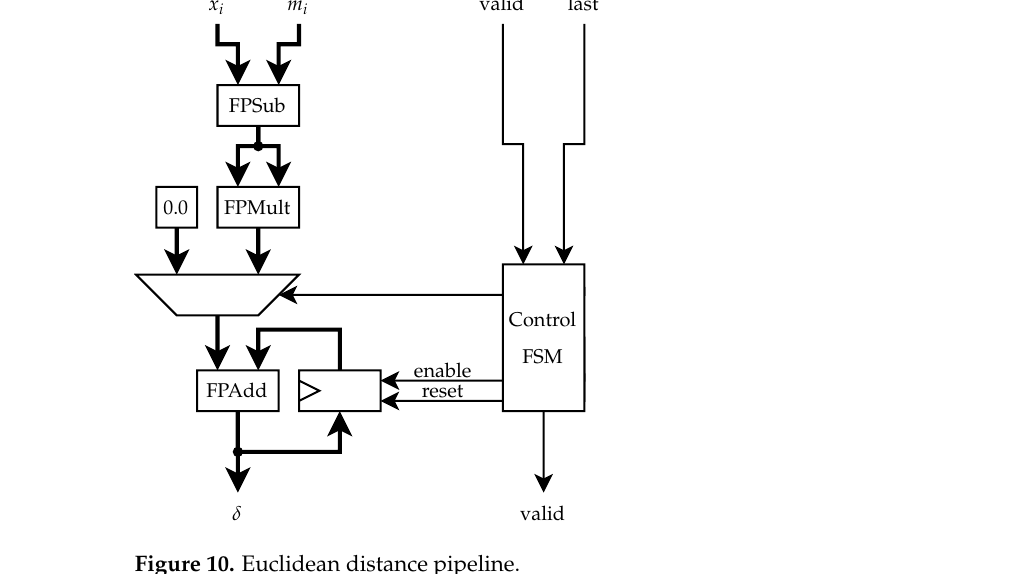
Figure 10. Euclidean distance pipeline.